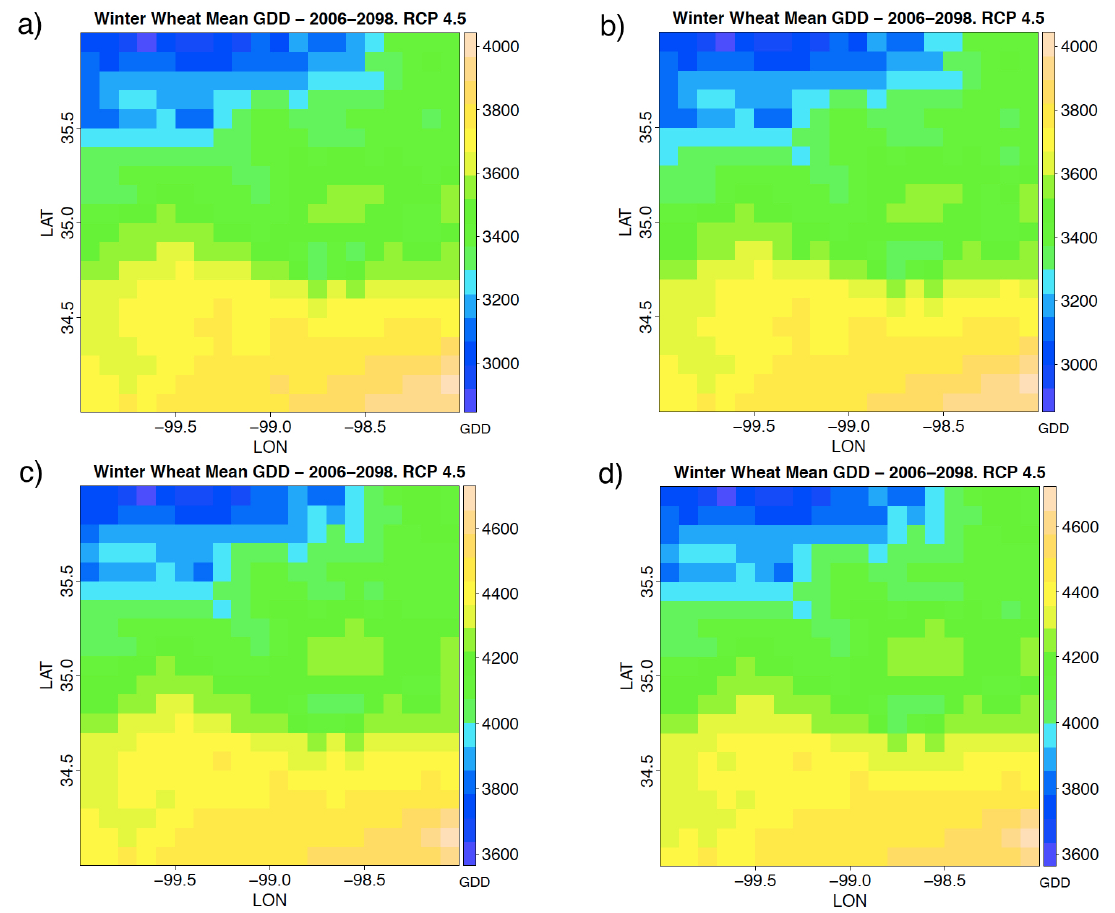
Figure 6. Mean GDD derived from the RCP 4.5 future projections (2006–2098) and four GCM/downscaling model combinations: ( a ) Top left—outputs for the CCSM4 GCM and CDFt downscaling method, ( b ) Bottom left-outputs for the CCSM4 GCM and EDQM downscaling method, ( c ) Top right—outputs for the MIROC5 GCM and CDFt downscaling method and, ( d ) Bottom right shows the outputs for the MIROC5 GCM and EDQM downscaling method.